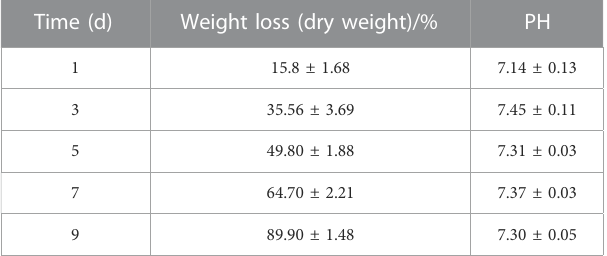
TABLE 1 Weight loss and PH value of PTMC fi lms after enzymatic digestion. Time